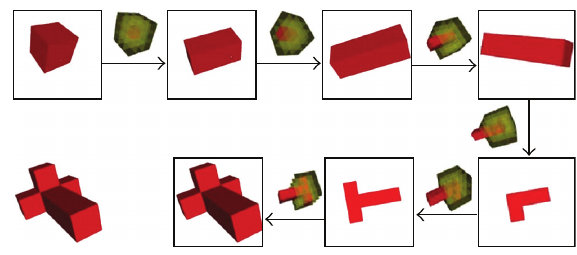
Figure 6: The constructing process of a plane model.